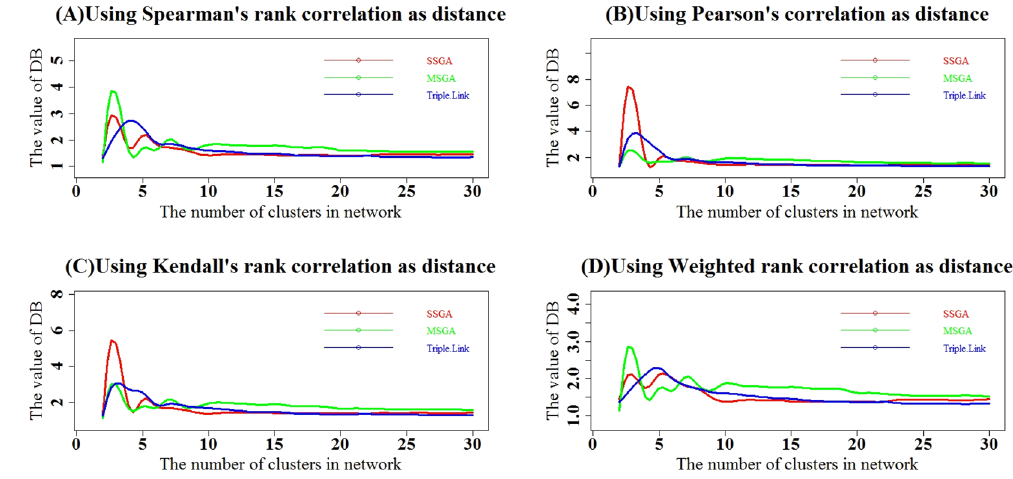
Figure 5. Comparison of SSGA, MSGA and Triple-Link Algorithm with the cumulative Davies-Bouldin (DB) indices. The cumulative DB indices of top i subnetworks derived from SSGA, MSGA and Triple-Link Algorithm where i = (2, … , 29, 30). ( A ) The distances used for calculating DB were based on Spearman’s rank correlation; ( B ). The distances used for calculating DB were based on Pearson correlation; ( C ). The distances used for calculating DB were based on Kendall’s rank correlation; ( D ). The distances used for calculating DB were based on Weighted Rank correlation. In all cases, a higher DB index of top i subnetworks reflects a more tightly averaged coordination of the top i